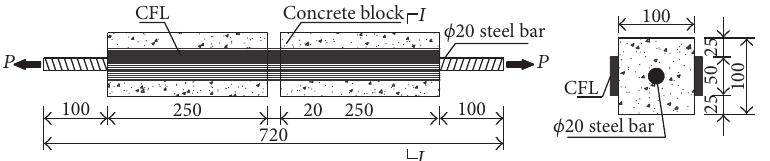
Figure 1: Schematic diagram of a double shear specimen (unit: mm).